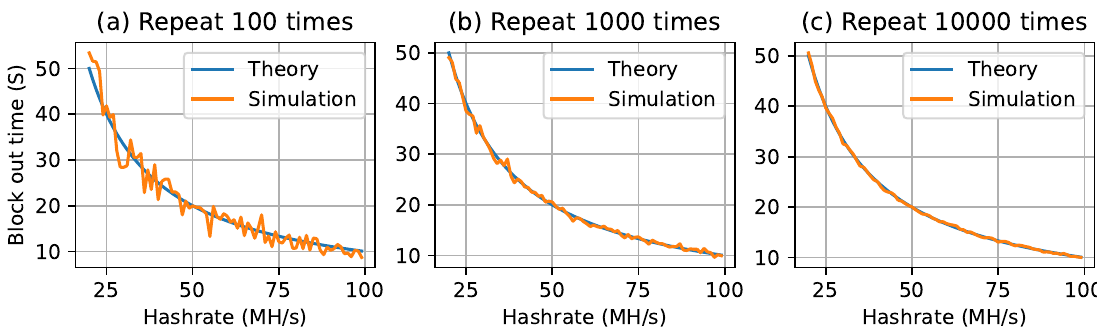
Figure 5. The simulated block generation time and a comparison with the theoretical